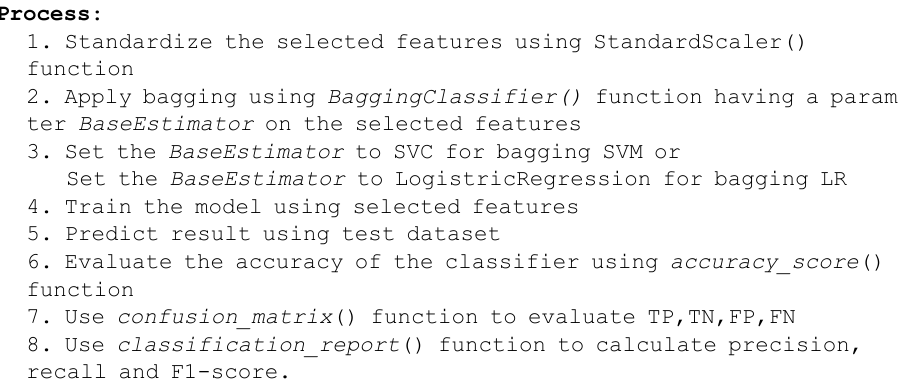
Algorithm 4. Abnormality detection using